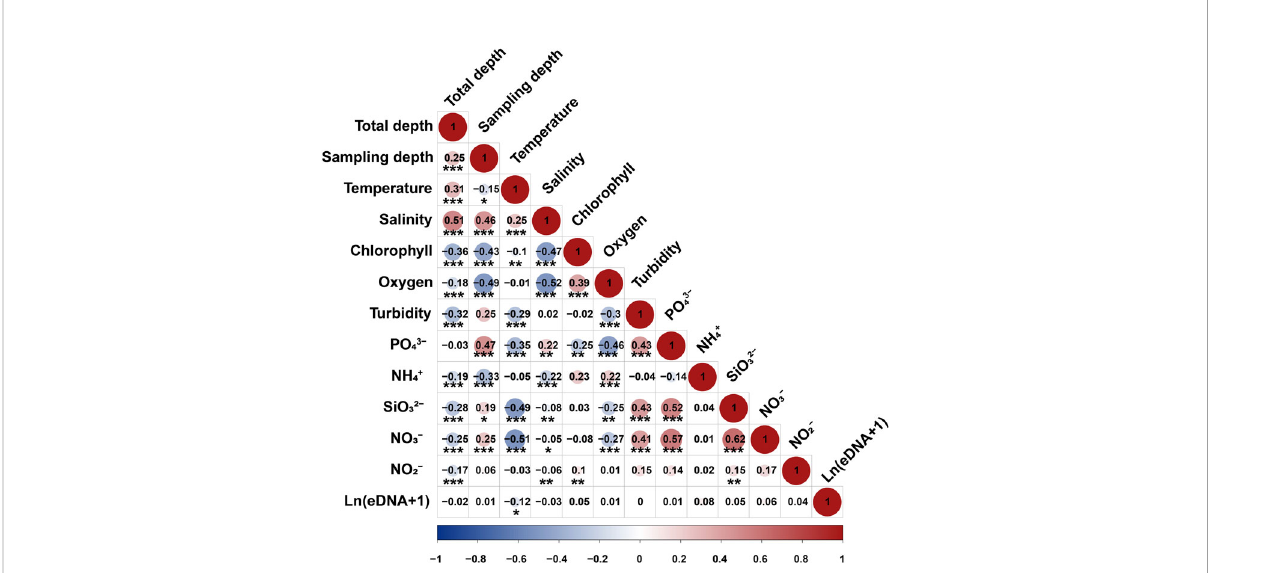
FIGURE 5 Correlation analysis between environmental variables and black sea bream environmental DNA (eDNA) concentrations (copies/L) as well as eDNA presence. The signi fi cance level is marked with * ( p -value < 0.1), ** (0.05 < p -value < 0.1), and *** ( p -value <